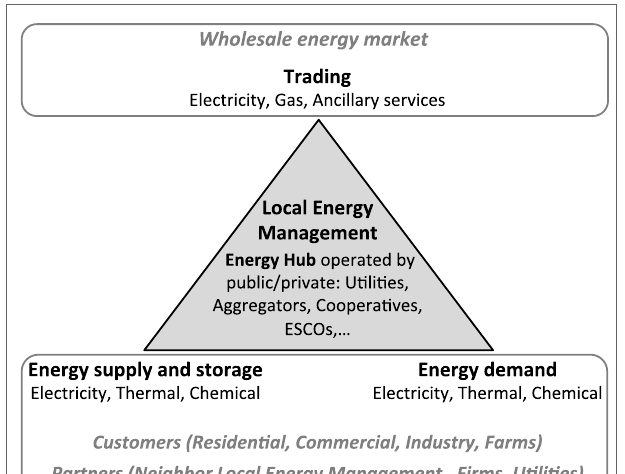
FigUre 1 | local energy management concept